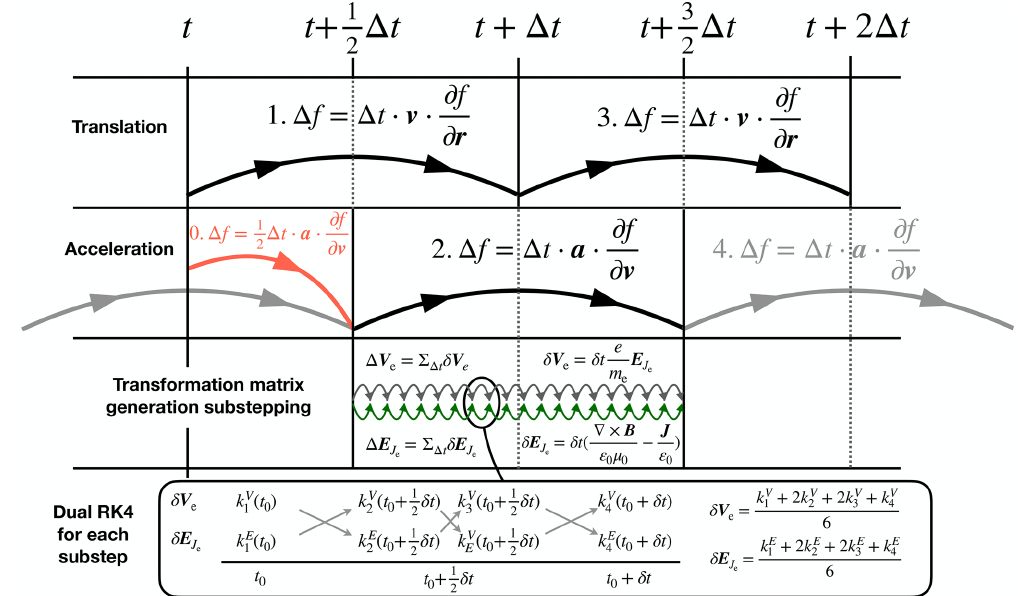
Figure 1. Electron solver procedure including substepping. At simulation start, a half-length acceleration step (0.) is performed. After that, translation (1, 3,... ) and acceleration (2, 4,... ) steps alternate in a leapfrog approach. Each acceleration step applies a transformation matrix which is generated in substeps, each of which updates electron acceleration δ V e and electric field change δ E J performed via a dual Runge–Kutta 4 algorithm over step lengths δt with Runge–Kutta coefficients k E Hoilijoki et al. (2017), Juusola et al. (2018a), Juusola et